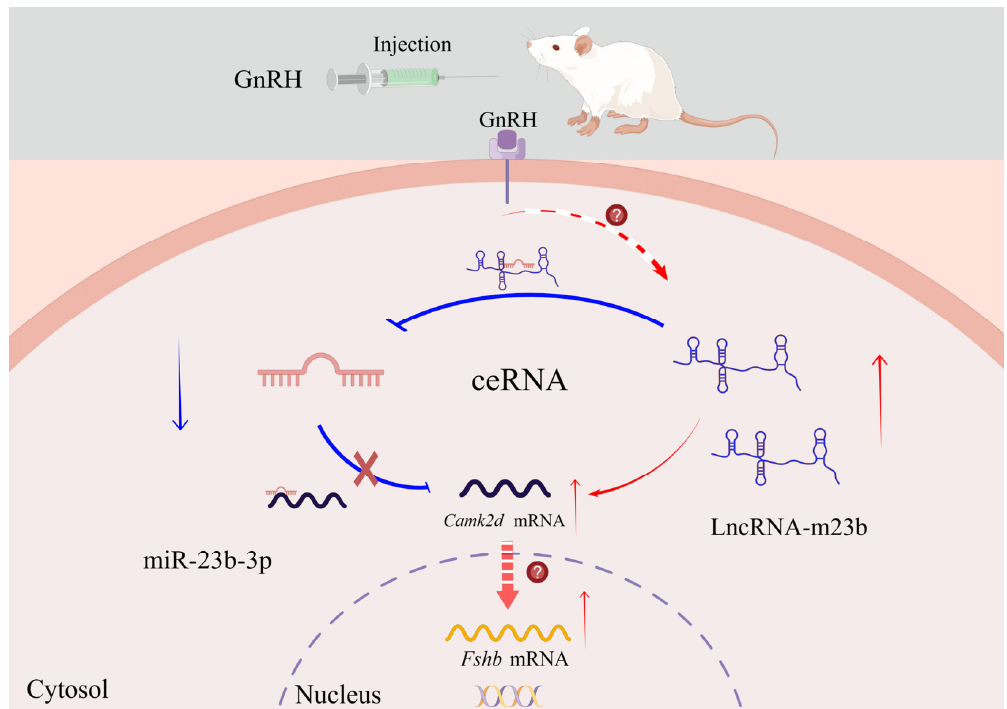
Figure 10. Schematic of the proposed lncRNA-m23b mechanism in rat anterior adenohypophysis cells. The blue arrows on the diagram represent inhibition, and the red arrows represent facilitation. This figure was drawn using Figdraw (https://www.figdraw.com/static/index.html#/, accessed on 2 March 2023). The unique authorization code is UOWUU765ca.